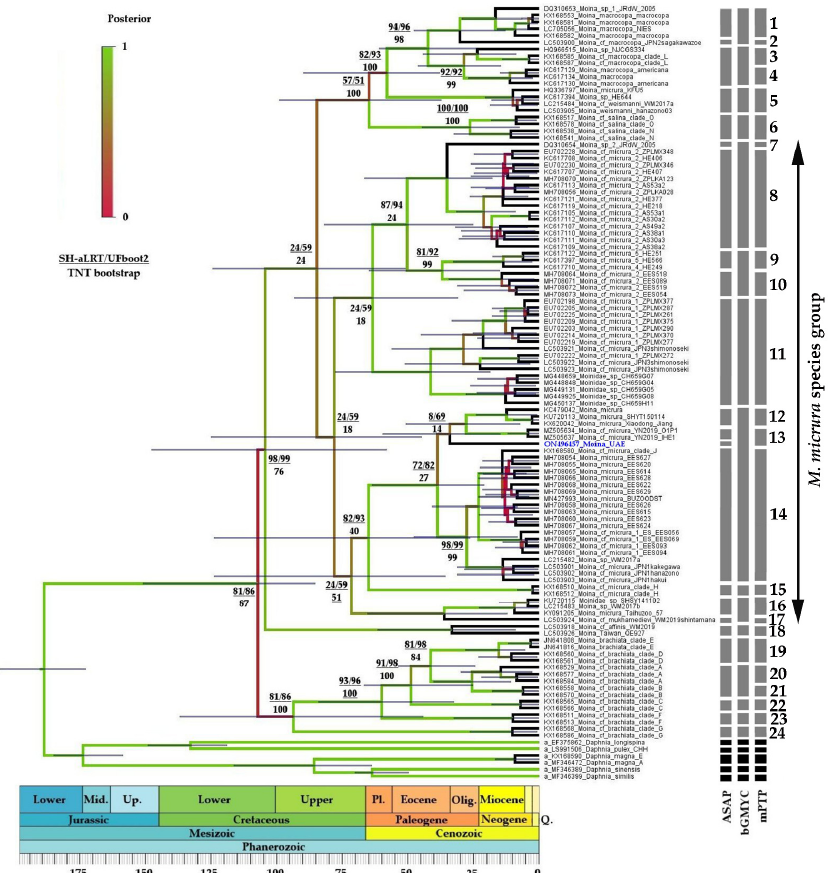
Figure 21. Phylogenetic ultrametric tree based on COI mitochondrial gene for Ceriodaphnia with relaxed molecular clock estimates based on fossil calibration points. Sequence from UAE is marked with blue colour. Prior probability of branches is coded by the colour gradient from red (low) to green (high). Node supports for key points are: value of the SH-aLRT for the first digit/value of UFboot2 (ML) for the second digit and standard (TNT) bootstrap value in the denominator. The bars depict the 95% highest probability density (HPD) interval of the estimated divergence times. Results of delimitation based on p -distance (ASAP), the Bayesian general coalescence model (bGMYC) and multi-rate Poisson tree processes (mPTP) are represented by grey bars on the right side.